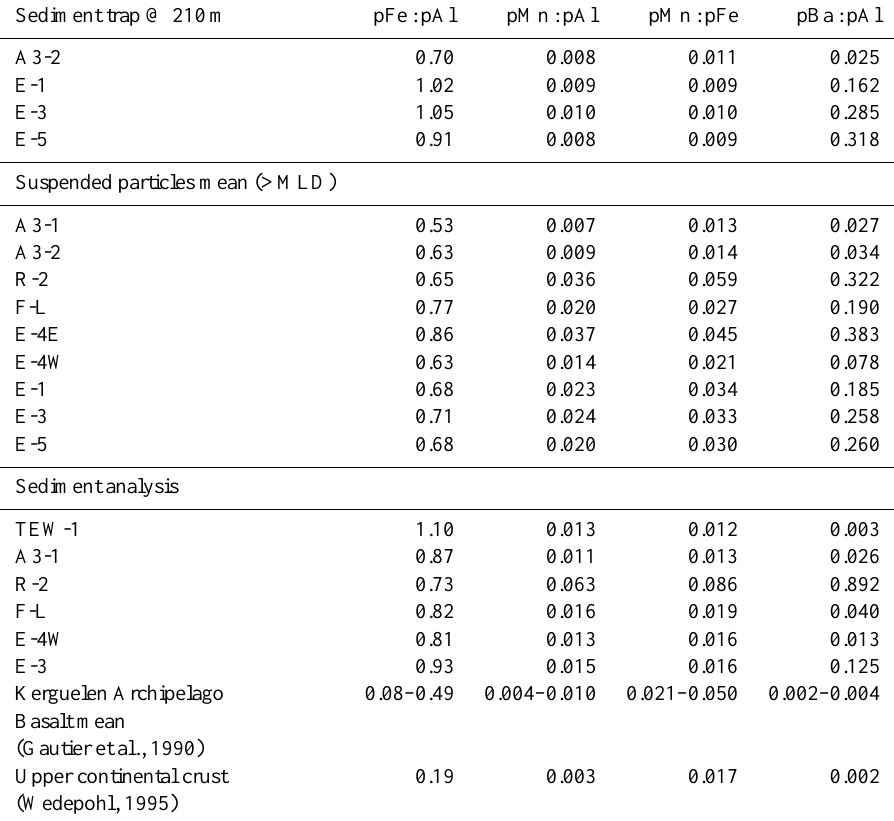
Table 2. Mean elemental molar ratios of marine snow particles captured in free-floating sediment traps, particulate matter (1–53µm) below the mixed layer and authigenic sediments at each station. Note that station TEW-1 is a near-coastal station located within Hillsborough Bay, Kerguelen Island. Station TEW-1 is not discussed in detail in the MS as no samples were collected for suspended particles; however, details are included here to show the influence of close proximity to the island and fluvial/glacial